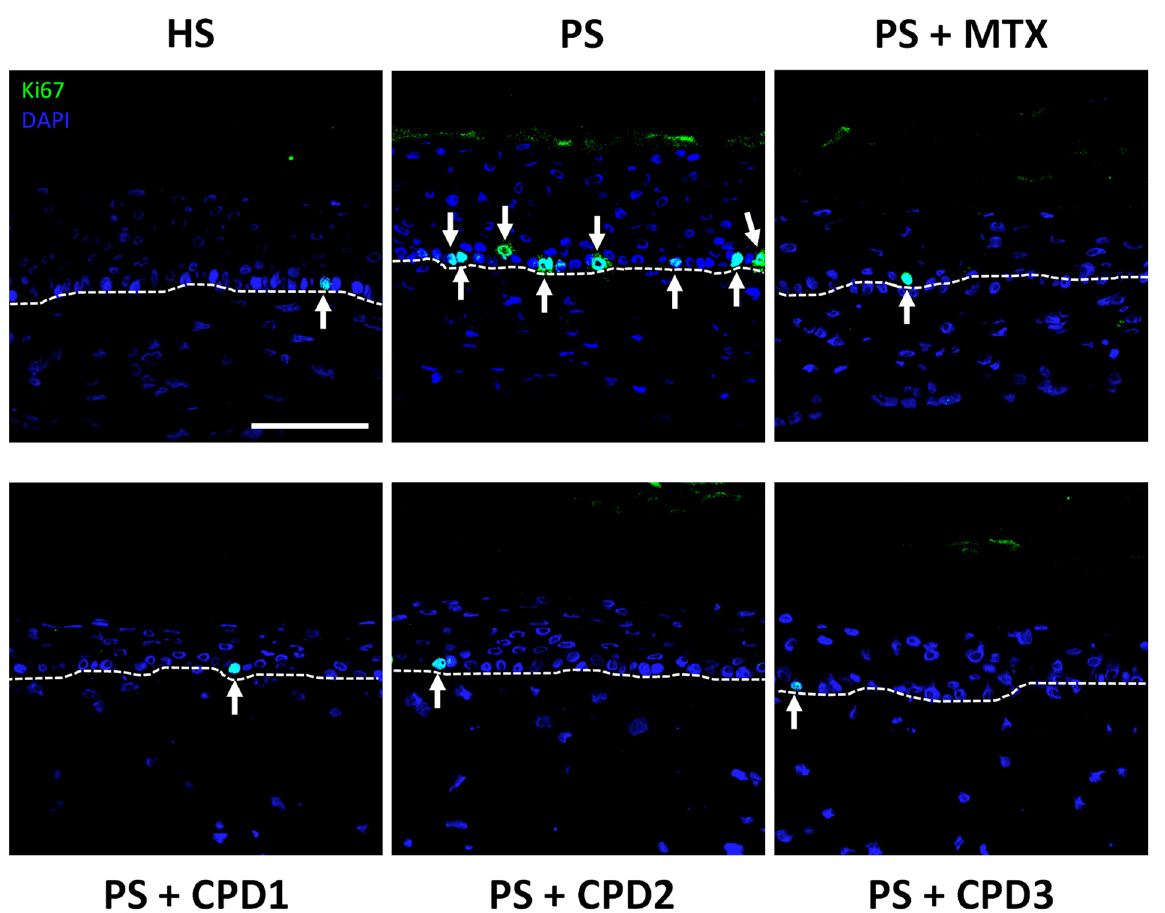
Figure 3. Immunofluorescence staining of a proliferation marker (Ki67, green). Expression of Ki67 (stained cells are indicated with arrows) in healthy substitutes (HSs); psoriatic substitutes (PSs); and psoriatic substitutes treated with methotrexate (MTX), quebecol (CPD1), ethyl 2,3,3-tris(3-hydroxy-4-methoxyphenyl)propenoate (CPD2) and bis(4-hydroxy-3-methoxyphenyl)methane (CPD3). Nuclei were stained with Hoechst (blue). The dotted white line represents the dermo-epidermal junction. Scale bar: 50 µ m. Each staining is representative of three different cell populations.